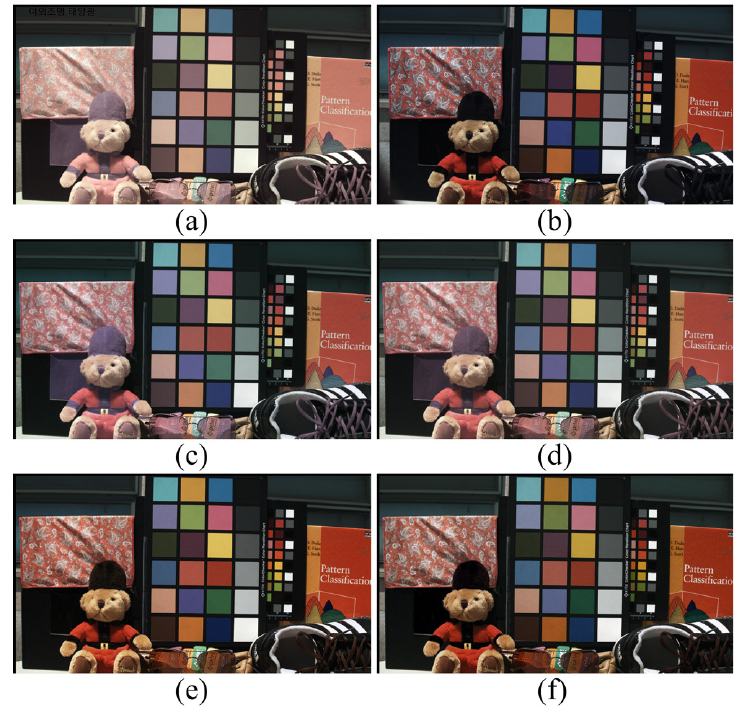
Figure 18. Experimental results under sunlight (400 lx) ( a ) Input image ( b ) optical filtered visible band image; ( c ) 3 × 3 CCM; ( d ) 3 × 4 CCM; ( e ) root-polynomial mapping; ( f ) proposed